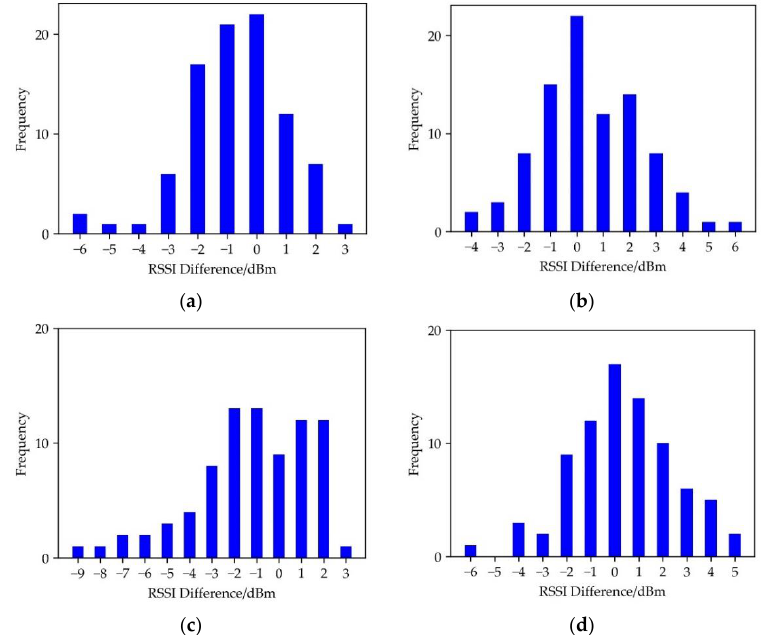
Figure 8. Histogram of ∆ R in the fourth quadrant and ( a ) Histogram of ∆ R in the direction of AA (cid:48) , ( b ) Histogram of ∆ R in the direction of BB (cid:48) , ( c ) Histogram of ∆ R in the direction of CC (cid:48) , ( d ) Histogram of ∆ R in the direction of D (cid:48) D